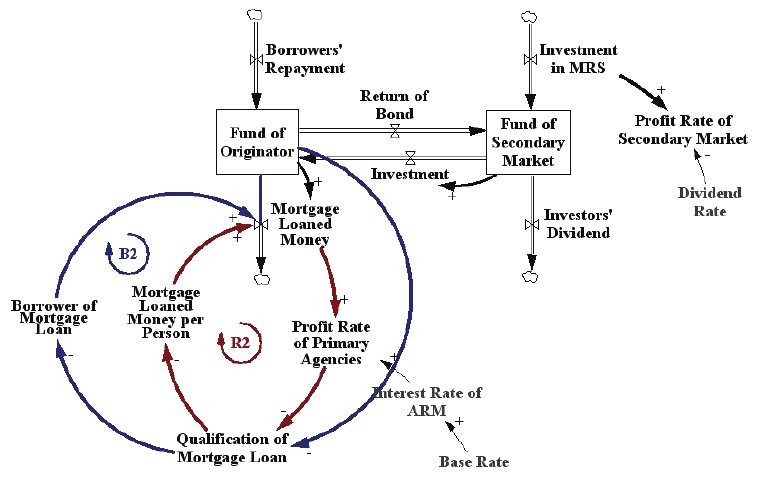
figure 5. Real estate financial market structure